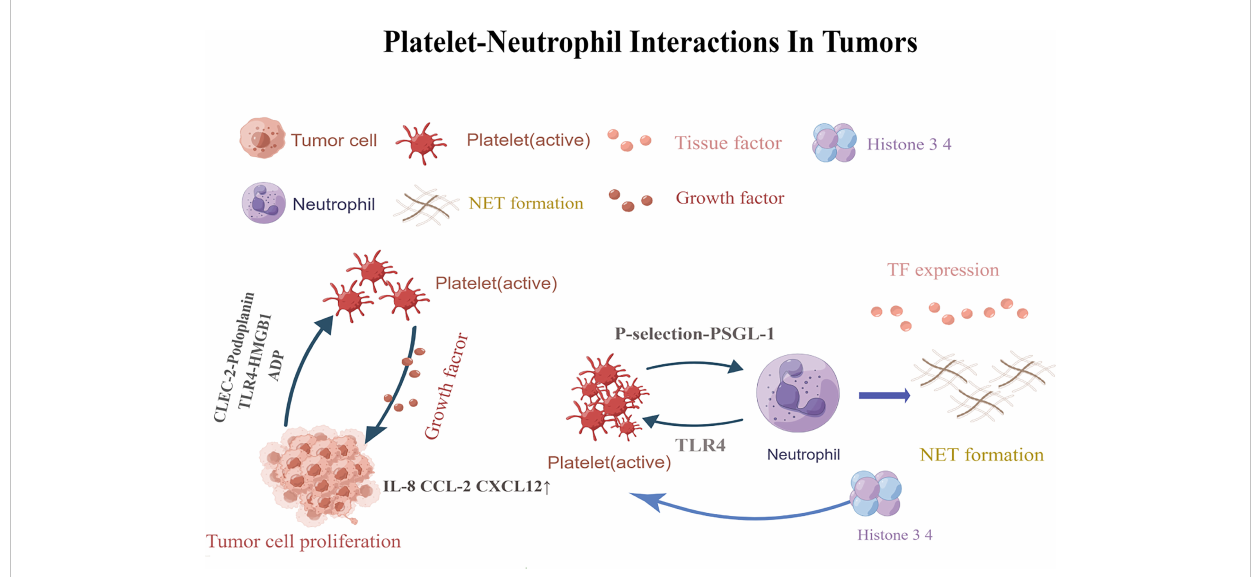
FIGURE 1 Platelets are activated by CLEC-2-podoplanin and TLR4-HMGB1.Activated platelets release factors that promote adhesion and angiogenesis, and increaseIL-8, CXCL12,and CCL2 levels. Eventually leading to tumor cell angiogenesis and tumor proliferation. P-selectin-PSGL-1 promotes the formation of neutrophil traps. TLR4-induced platelet activation can induce platelets to bind to neutrophils and form robust NETs, releasing histones 3 and 4, which further activate circulating platelets and promote the formation of more NETs.CLEC-2,C-type lectin-like immune receptor 2; TLR4, Toll-like receptor; HMGB1,high-mobility group box 1; PSGL-1,P-selectin glycoprotein ligand 1; NETs, Neutrophil extracellular traps. This fi gure is drawn by Figdraw (https:// fi gdraw.com/). The " ↑ " arrows refer to the increased expression of IL-8, CXCL12, and